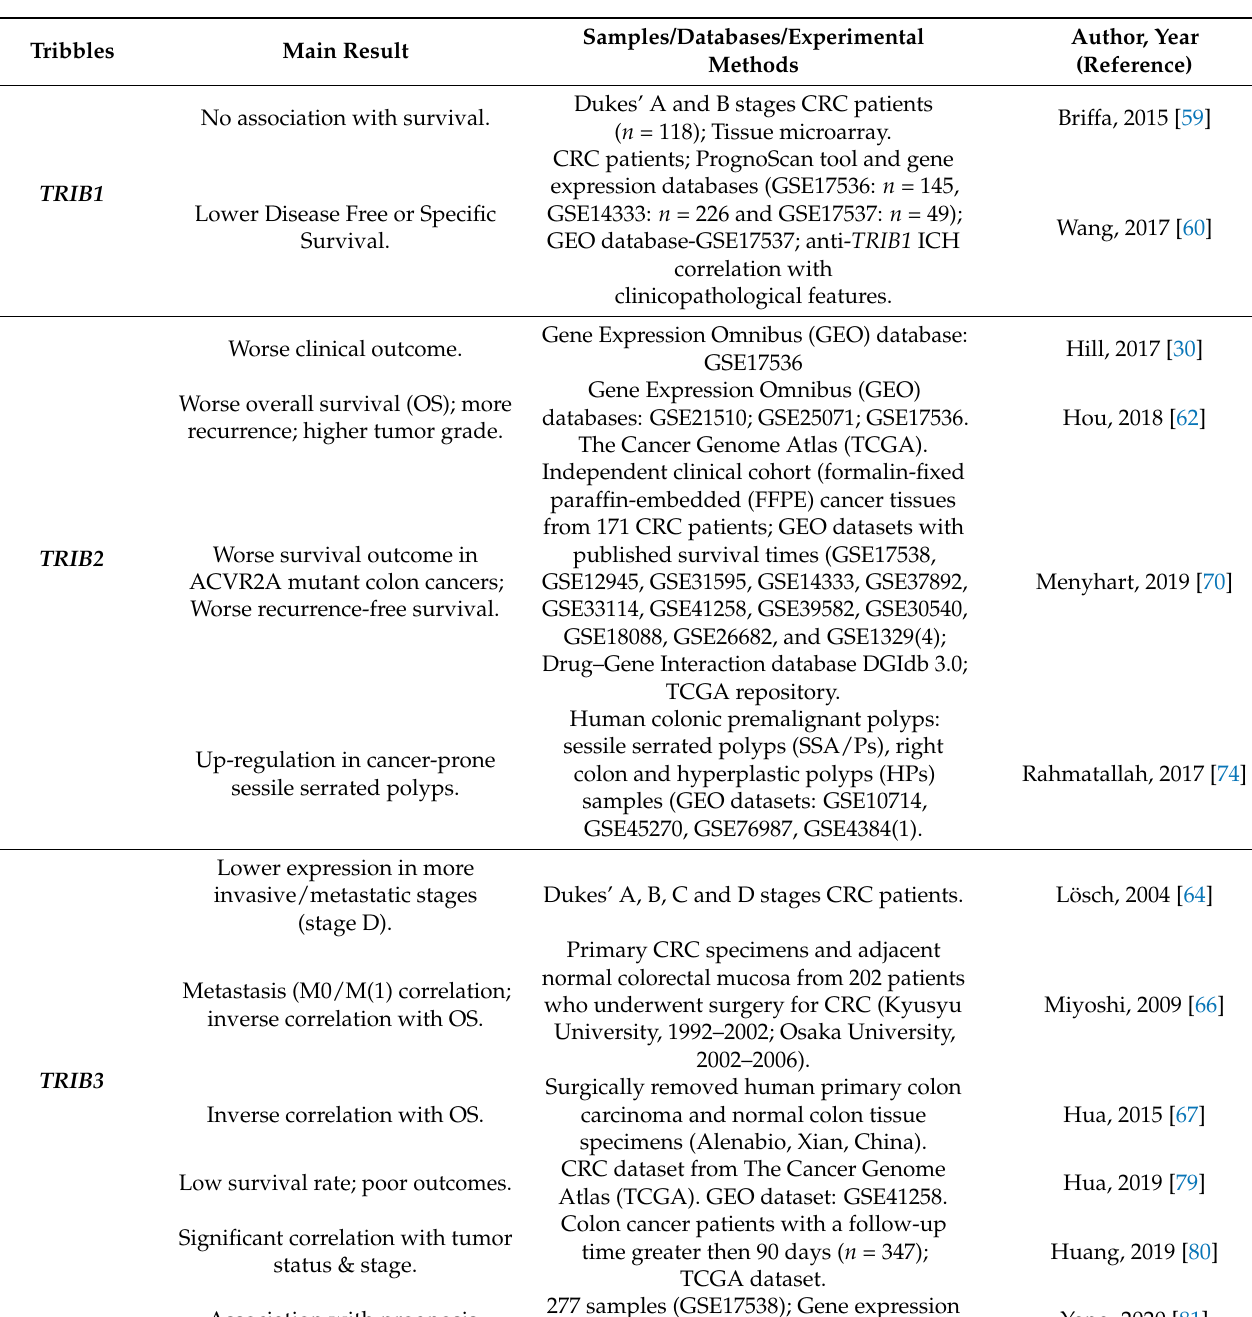
Table 2. Clinical significance of Tribbles overexpression in colon cancer. Main results regarding the correlation between the expression of each Tribbles family member and its clinical impact. Sample details, databases and methodology used by the authors is detailed under the respective